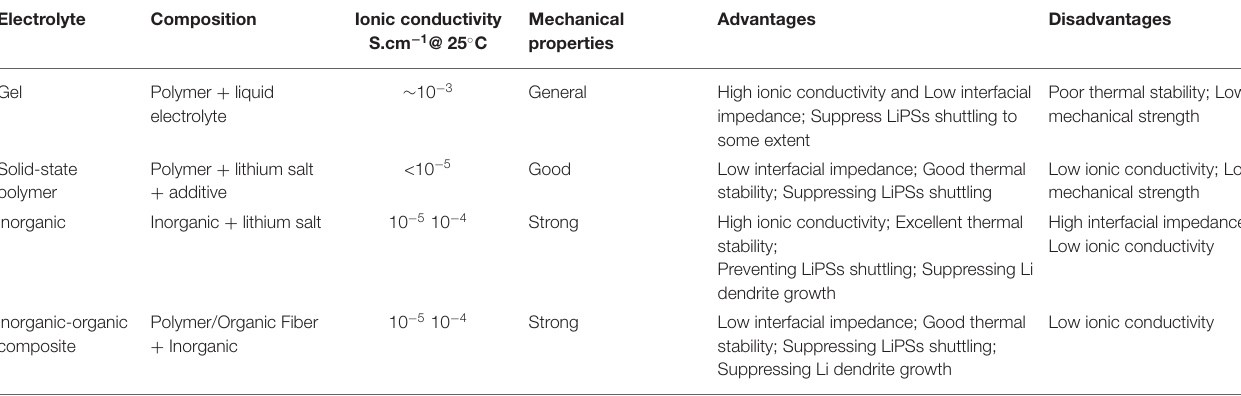
TABLE 1 | Comparison of composition and performance of different